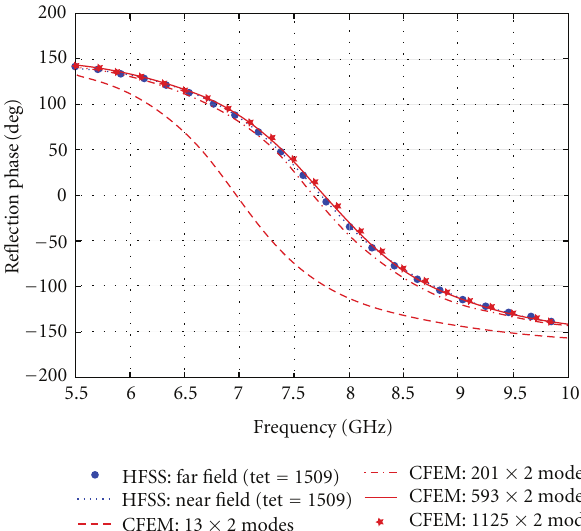
oblique angles. In this case, the built-in R/T calculation in